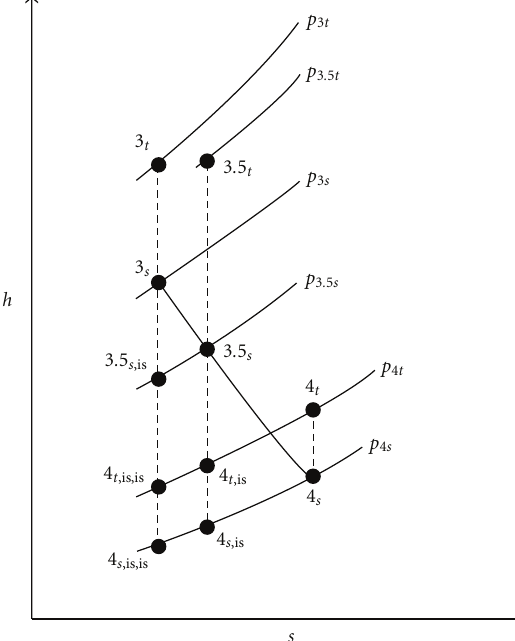
Figure 3: Enthalpy-entropy diagram of an expansion process within a